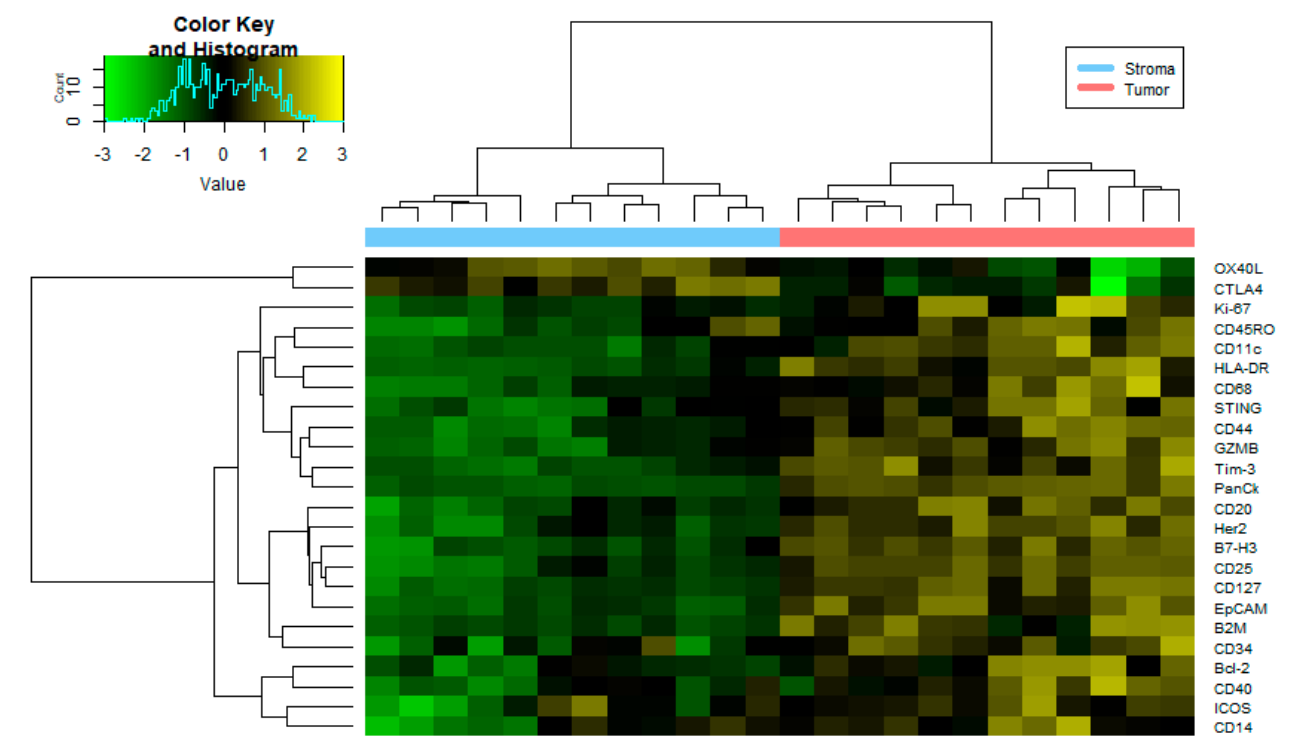
Figure 2. Heatmap of protein expression differences between stroma and tumor tissue. Heatmap generated using the normalized expression values for 24 proteins from an immunology/oncology panel (FDR < 0.2 and p -value < 0.05) that were differentially expressed among 12 tumor ROIs and 12 tumor-adjacent ROIs. See Supplementary Table S2 for numerical data. I/O = immune/oncology; FDR = false discover rate; ROI = region of interest.